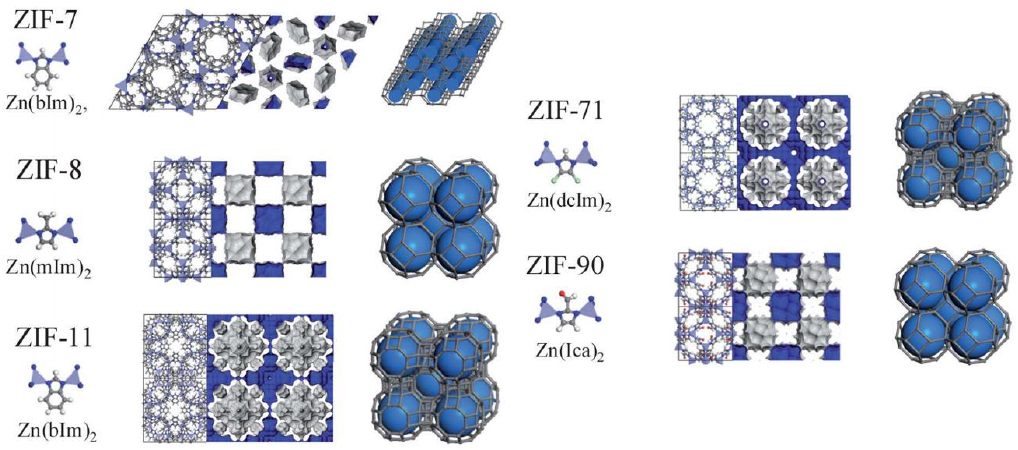
Figure 1. Zeolitic Imidazolate Frameworks (ZIF) structures with building blocks, topology, and accessible surface area for a probe diameter of 2 Å. Adapted from [42], with copyright permission from © 2012, Royal Society of Chemistry.